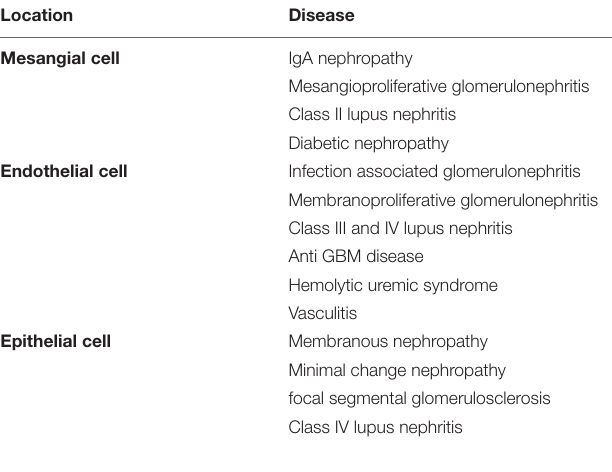
Table of Contents: Kidney disease has become a global health problem. And with nanotechnology, therapeutic agents can achieve selective accumulation at the kidney, and thus reduce the side effect and increase drug concentration on the diseased site. Here we summarized recent advances in nanoparticles designed for kidney targeted delivery according to the targeting